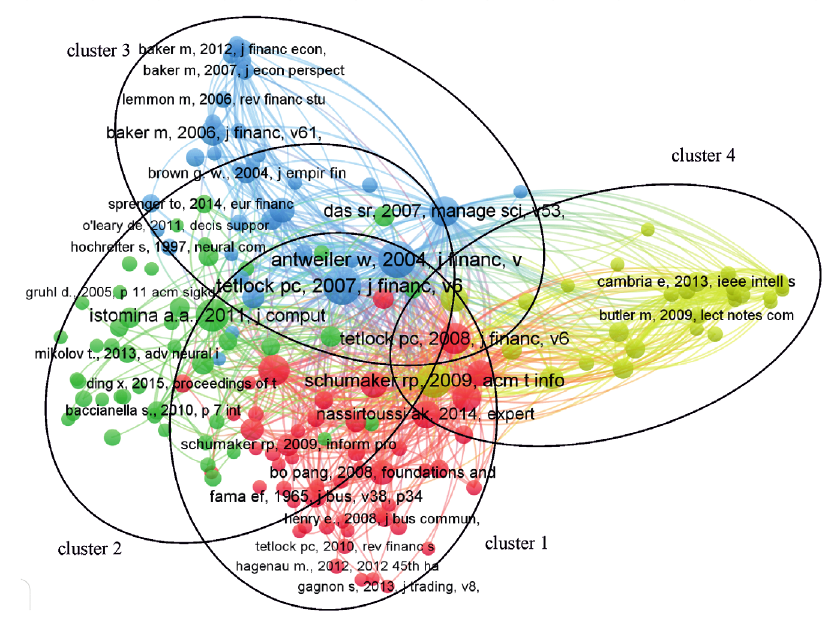
Figure 4. Results of bibliometric co-citations of references